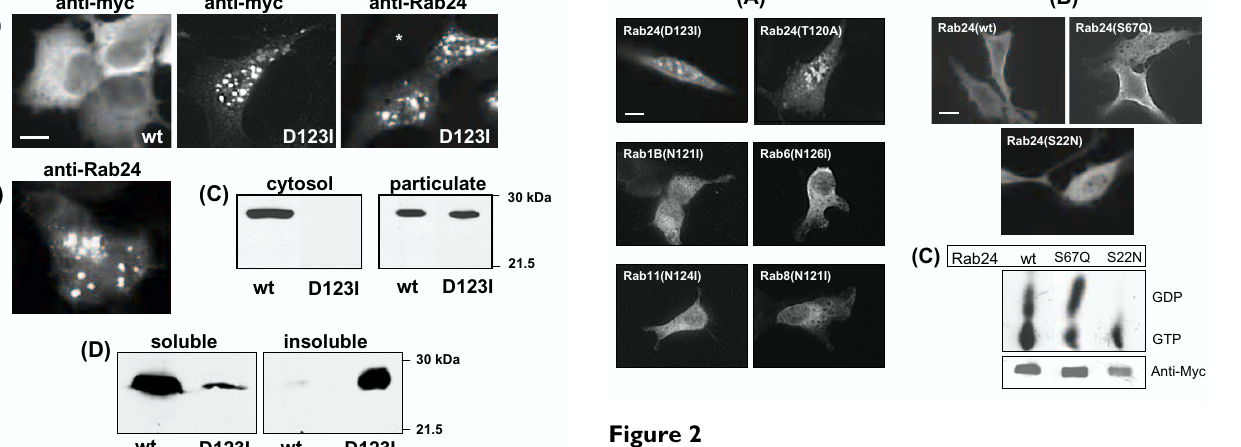
Figure 2 Localization of different Rab GTPases with amino acid substitutions in the N(T)KxD nucleotide binding motif. (A & B) NIH 3T3 cells were transfected with pCMV5 vectors encoding different myc-tagged Rab proteins with the indicated amino acid substitutions. Twenty-four hours after transfection, cells were processed for immunofluorescence microscopy, using the anti-myc monoclonal antibody, fol- lowed by FITC-conjugated GAM IgG. Non-transfected cells cannot be seen at the exposure setting used for the photo- graphs. The bar in the upper left panel is 10 microns. (C) Autoradiogram of a thin-layer plate showing 32 P-labeled GDP and GTP eluted from the indicated immunoprecipitated pro- teins. The immunoblot in the lower panel compares the rela- tive amount of mycRab24 collected in 1/10 of each